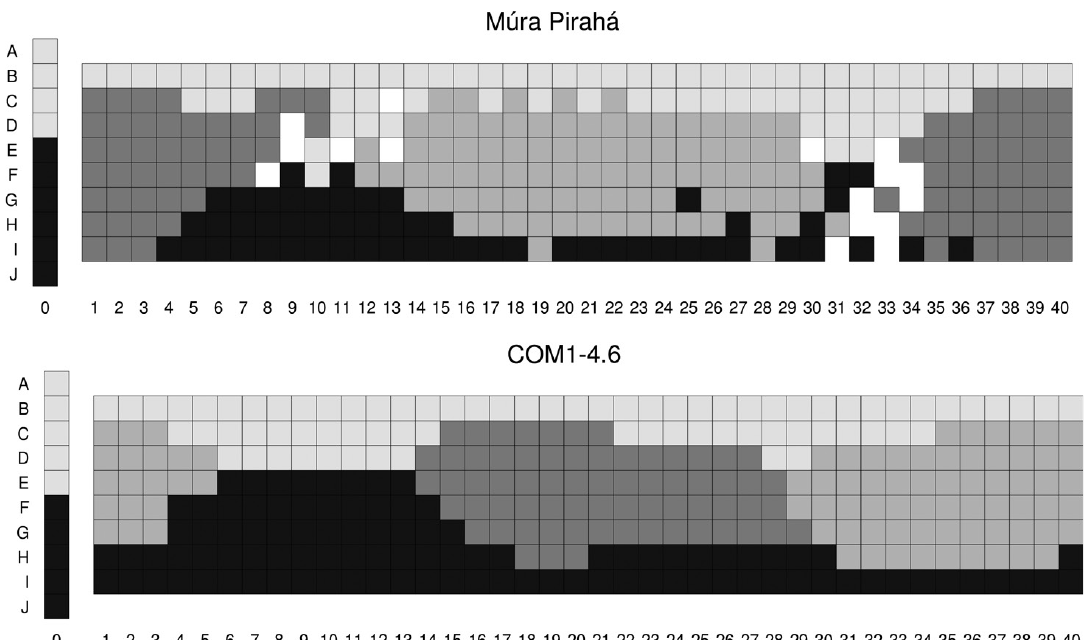
Figure 6: A 4-term WCS language with a term in the green region, and a similar result from the first variant of our